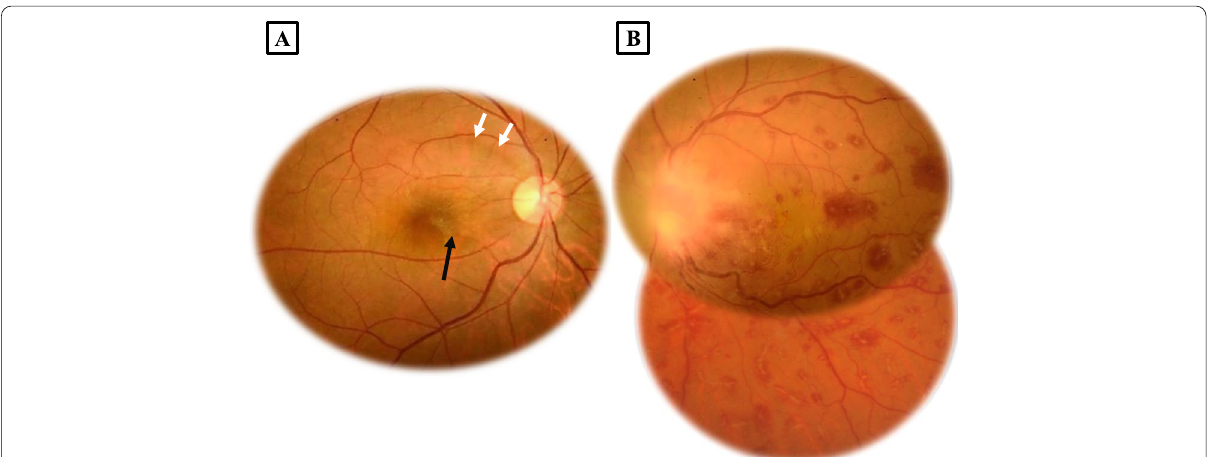
Fig. 1 A Fundus photograph of the right eye exhibiting an epiretinal membrane (black arrow) and a superotemporal bundle retinal fiber layer defect (white arrows). B Fundus photograph of the left eye showing a vitreous opacity overlying the optic nerve head, multiple dot and blot retinal hemorrhages and a vascular sheathing with frosted branch appearance